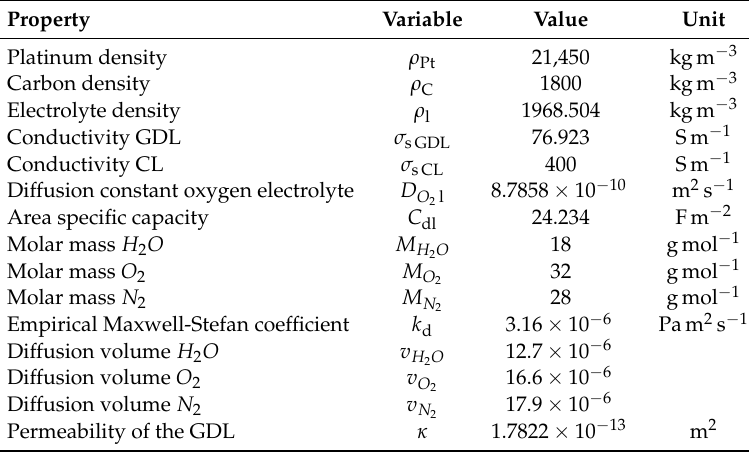
Table A1. Material parameters used in the final simulation model.